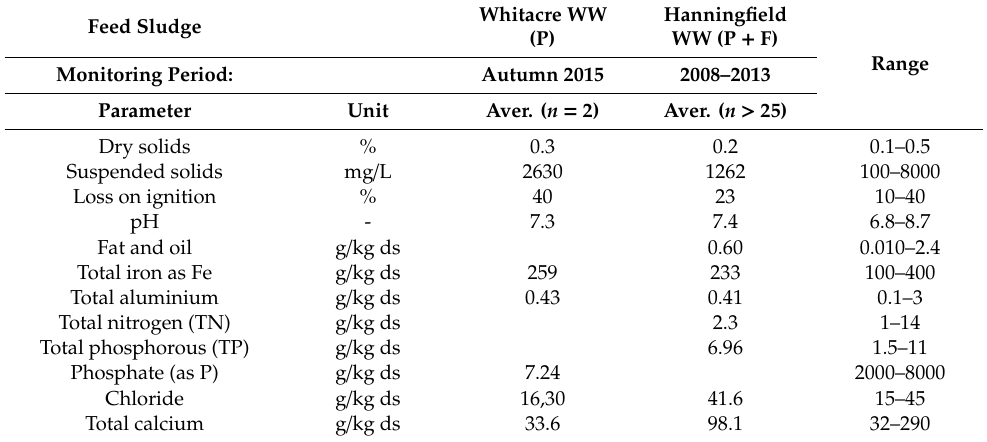
Table 4. STRB feed sludge characteristics at the Whitacre and Hanningfield WW (England). Both facilities utilize ferric sulphate as a coagulant (P = pilot, F = full-scale, WW = Water Works) [53,58,60].